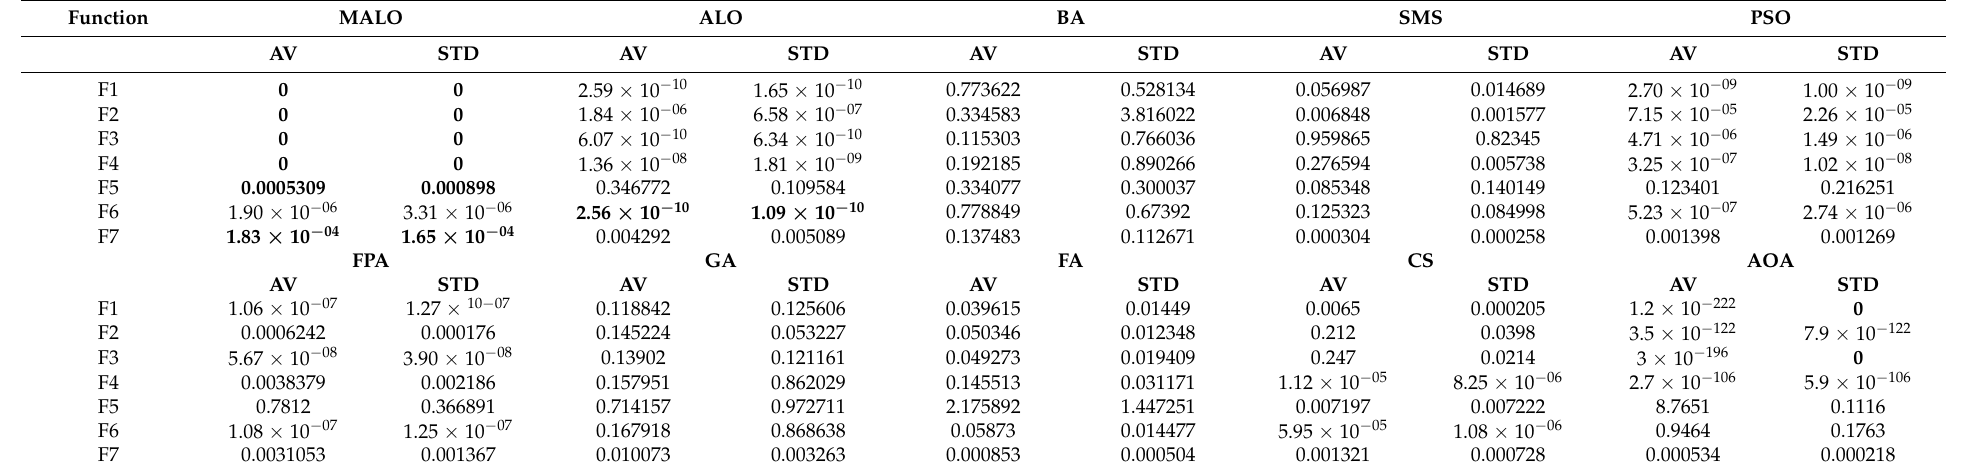
Table 5. Results of malo and other algorithms for unimodal functions (1000 iterations).